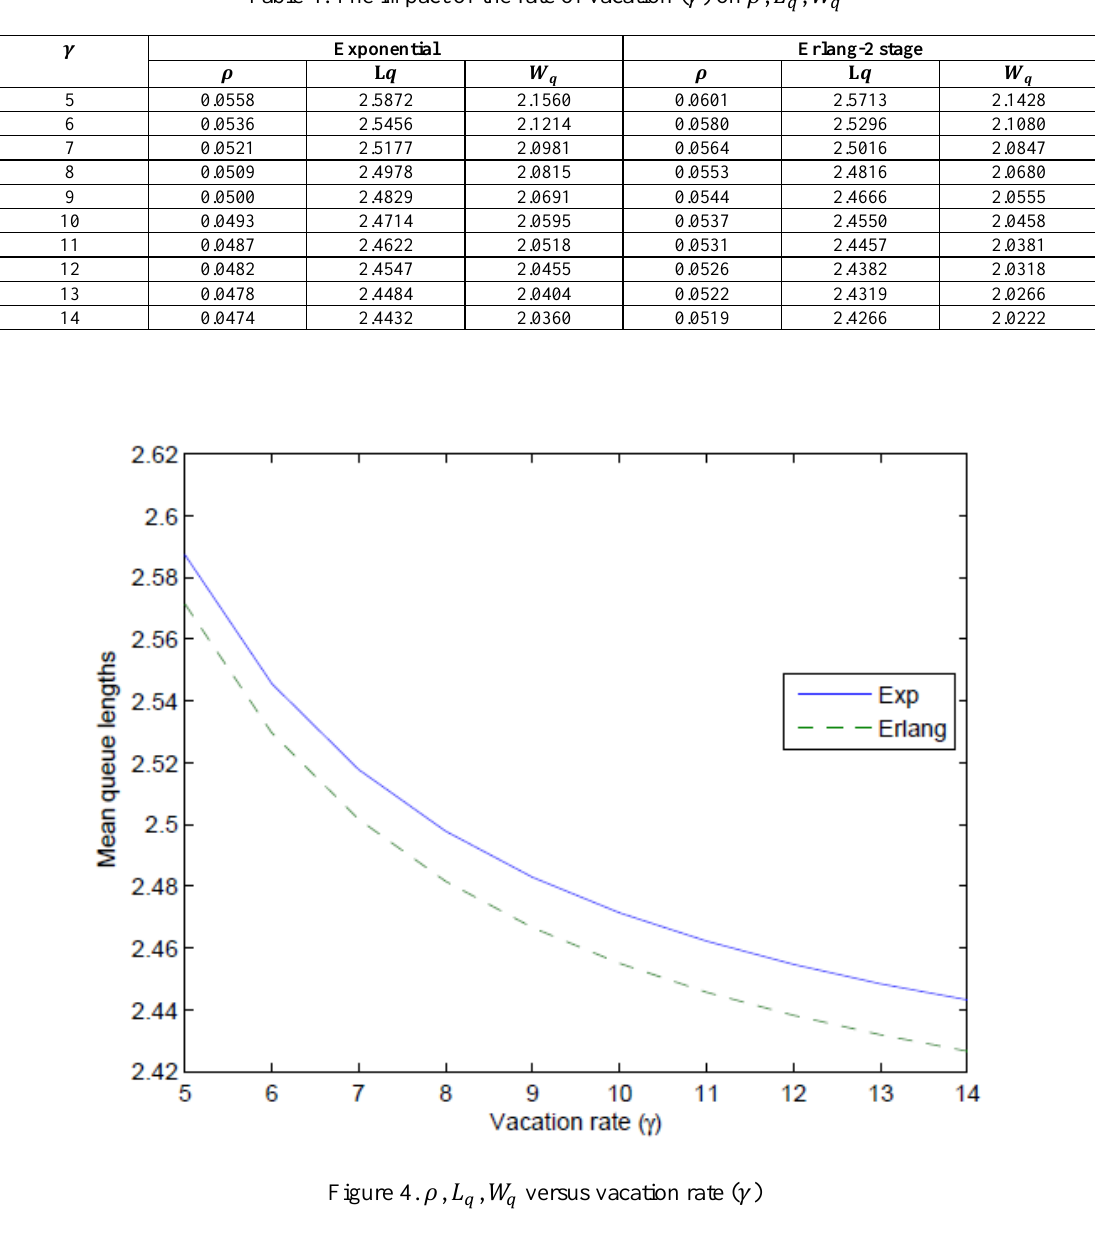
, 𝑊 versus vacation rate ( 𝛾 𝑞 𝑞